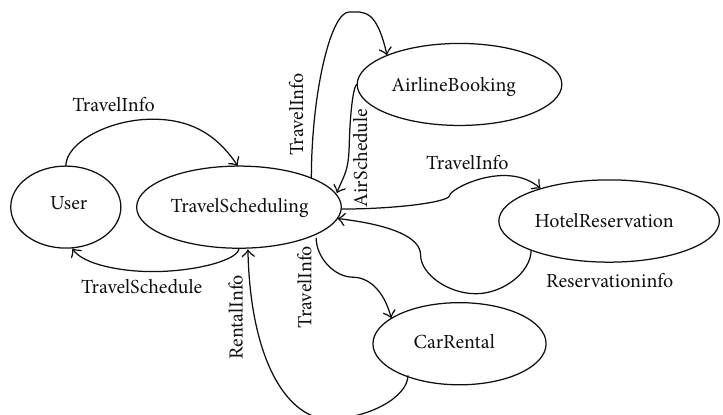
Figure 2: Illustrative state diagrams for travel scheduling.